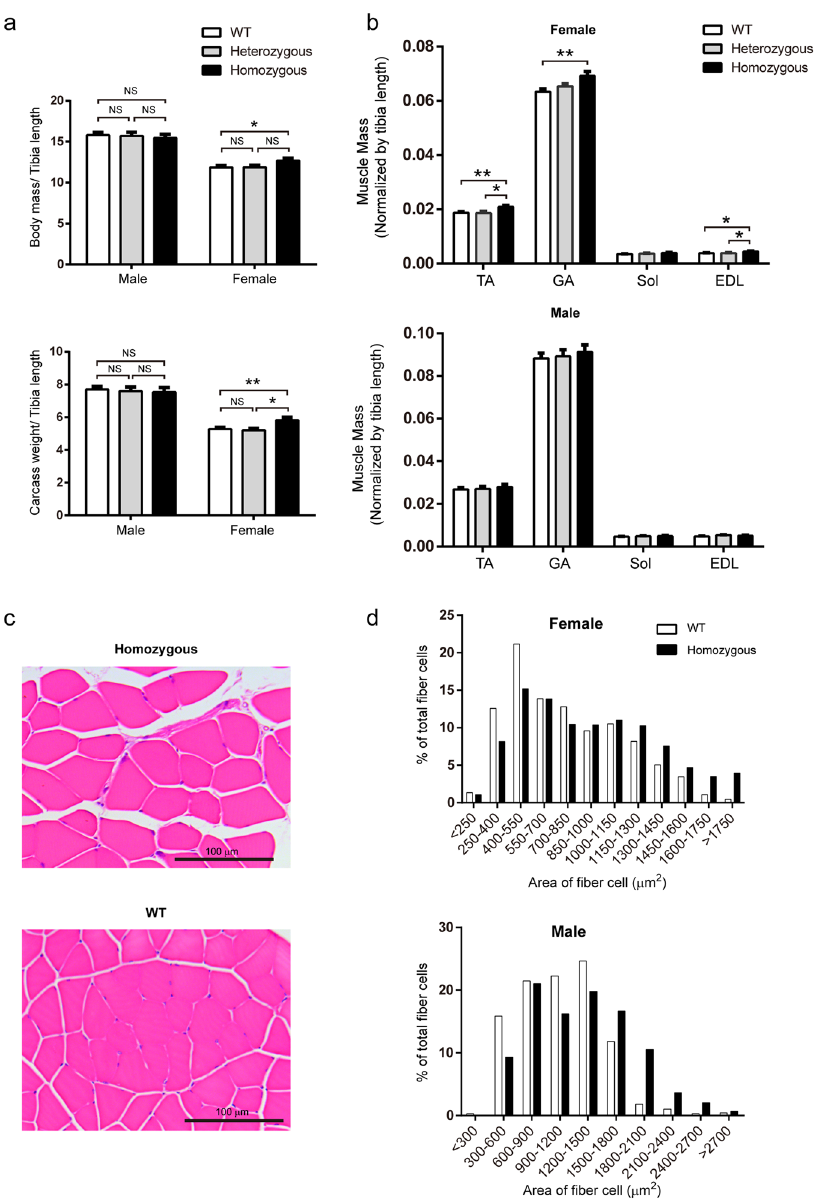
Figure 6. Detection of skeletal muscle hypertrophy in a genetically modified mouse model. (a) Average body mass (top) and carcass weight (bottom) of the three-month-old GM mice and sex-matched WT littermates (n = 8–15 per group). The body mass and carcass weight were normalized to the length of the tibia, respectively. (b) Determination of the muscle weight of the three-month-old GM mice and WT littermates (top, female mice; bottom, male mice). The data indicate the average weight of the muscles from the left and right sides. The muscle weight is normalized to the length of the tibia. (n = 10 for female homozygous GM mice, n = 8 for female heterozygous GM mice, and n = 15 for female WT mice; n = 10 for male homozygous GM mice, n = 8 for male heterozygous GM mice, and n = 12 for male WT mice). (c) Representative images of H&E-stained cross-sections of the TA muscle from three-month-old female GM mice and WT littermates. (d) CSA frequency distribution of myofibres in the TA muscle from three-month-old GM mice and sex-matched WT littermates (sections from at least five mice per group). Bars depict mean values, and error bars represent SEM. * P < 0.05, ** P < 0.01. Statistical significances were analysed by Student’s